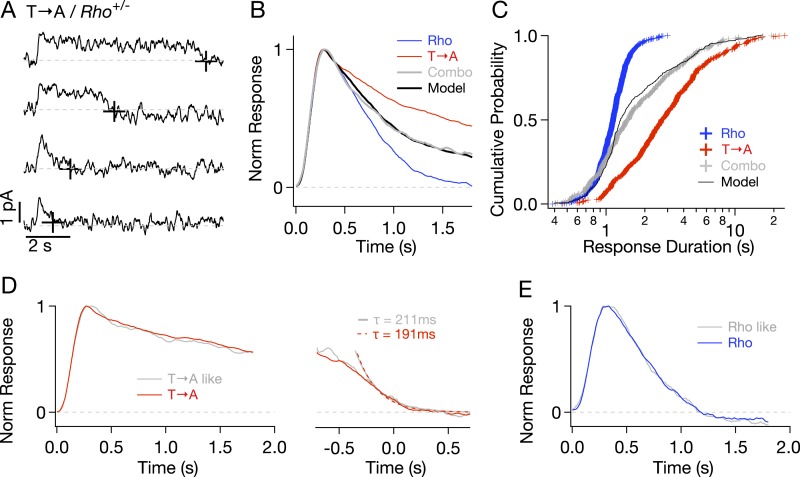
Comparison of single-photon responses from different rhodopsin mutants expressed in the same cell.(A) Representative SPRs from a T → A/Rho+/− cell, termed a ‘Combo’ rod. Response termination shown as black crosses. (B) Normalized response from Combo rods (gray) fit by a linear combination of normalized Rho and pure T → A responses. (C) Cumulative distribution of response durations from pure Rho and T → A rods and from Combo rods. A random selection of Rho and T → A response durations in a 1:1 ratio gives the modeled distribution (black line). (D-left) Average of initial phase of T → A responses (red) and combo responses (gray) classified as T → A-like (Figure 5—figure supplement 1). (D-right) Average tails of T → A-like responses aligned to the response ends, normalized to the peaks (left). Dotted lines depict decaying exponential fits to the combo tail (gray, τ = 211 ms) and T → A tail (red, τ = 191 ms). (E) Averages of Rho-like responses from WT and Combo rods.